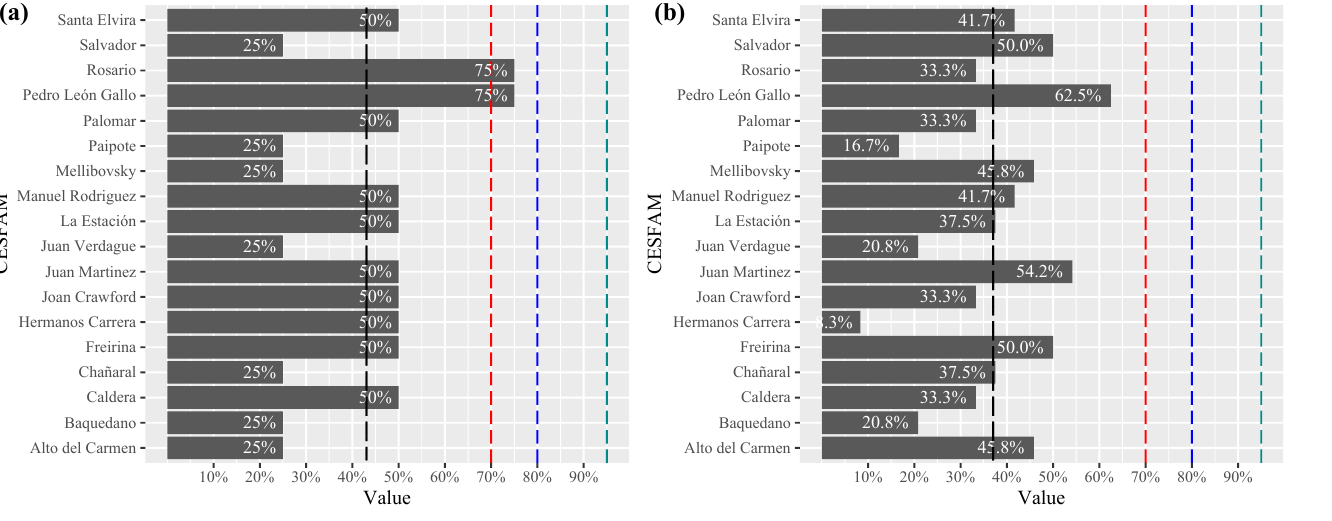
Figure 5. Level of compliance with the ( a ) first access chain, ( b ) second access chain. (Family Healthcare Center (CESFAM), mean dash – – black, lim 70% dash – – red, 80% dash – – blue and 95% dash – – green.)